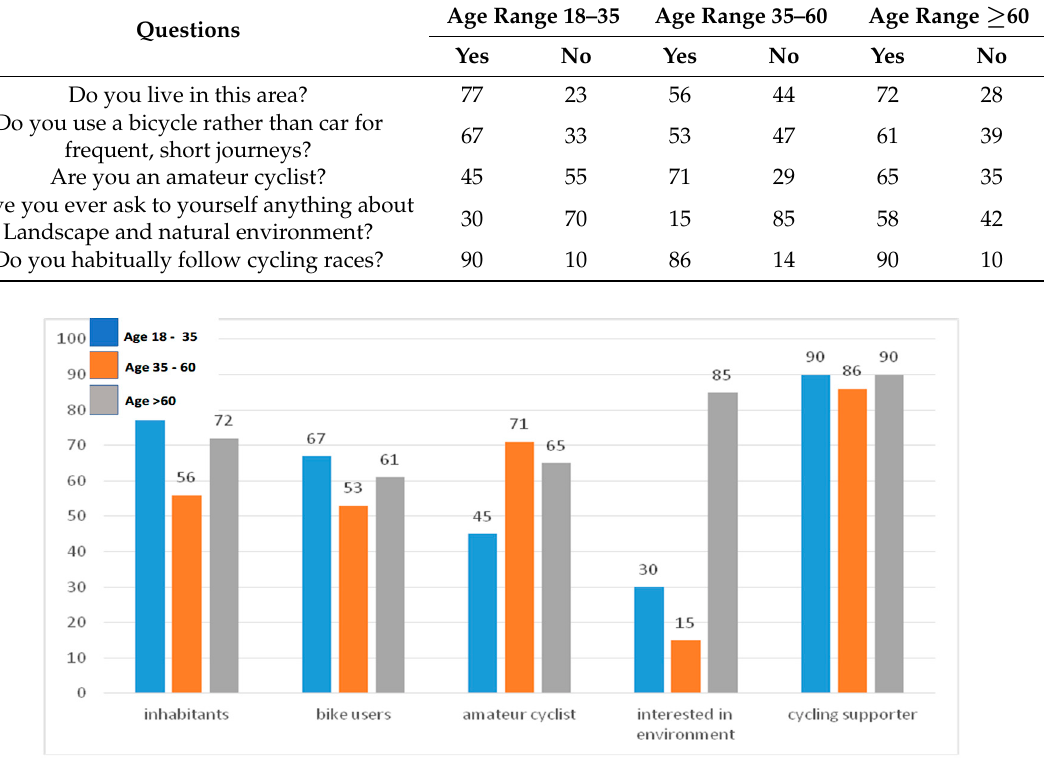
Figure 3. Diagram of personal involvement in cycling and environment. Table 2. Table of Personal interest in Sciences.